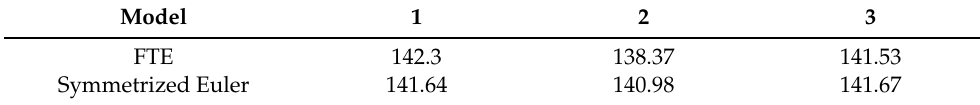
Table 5. Computational times (sec.) of Euler-type discretizations for 2 6 time steps and 2 × 10 7 paths.